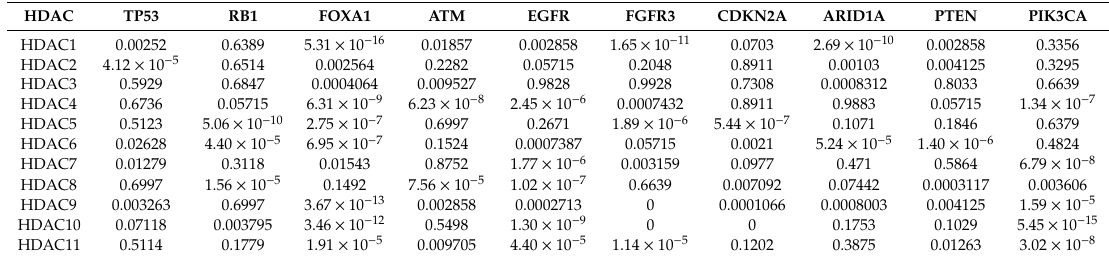
Table A2. q -values for HDAC genes and commonly mutated driver genes in